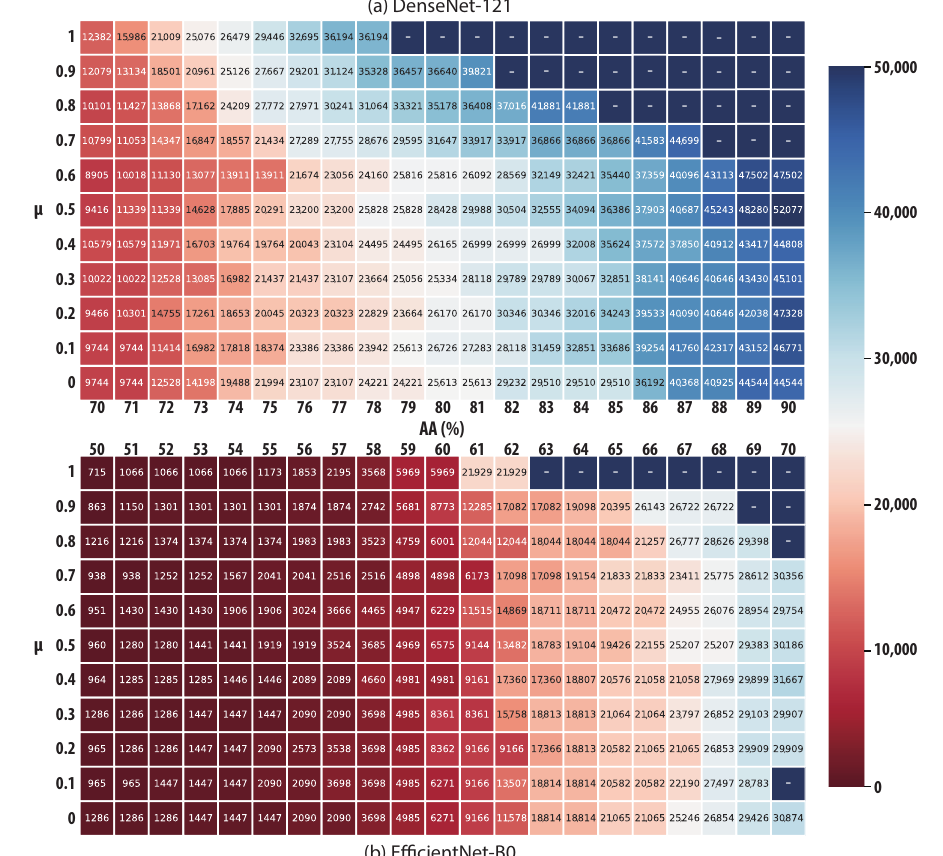
Figure 2. Heat map of the communication cost required to reach different AAs in ( a ) DenseNet-121 and ( b ) EfficientNet-B0. Note that “-” indicates that the AA cannot be reached.